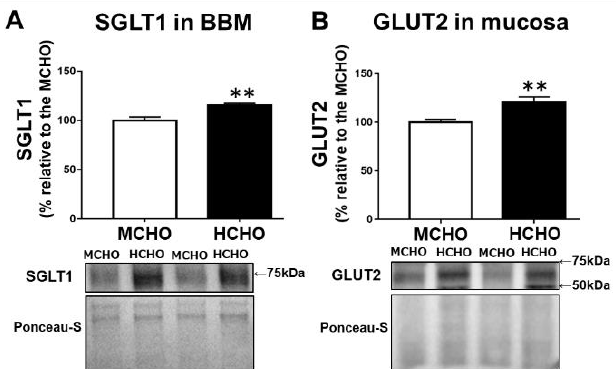
Figure 2. ( A ) The SGLT1 protein level in the brush border membrane (BBM) fraction extracted from jejunum mucosa and ( B ) the GLUT2 protein level in jejunum mucosa in mice fed the HCHO diet (black, n = 7) or the MCHO diet (white, n = 8) for 10 days. Values are mean ± standard error (SE). All data are shown as relative values against the MCHO group. ** p < 0.01 vs. the MCHO group.